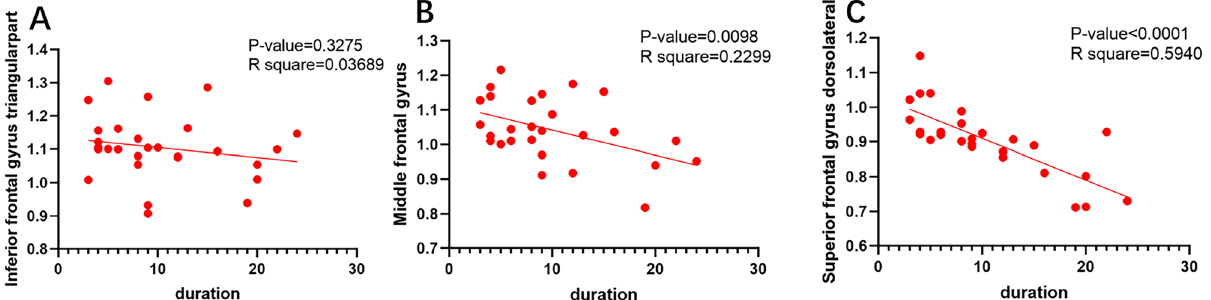
Figure 4. The correlation analysis between the course of the disease and the average ReHo of the brain area. ( A ) is the correlation between the ReHo value of awkward gyrus triangularpart and duration of disease (R square = 0.03689, P = 0.3275). ( B ) is the correlation between the ReHo value and duration of disease (R square = 0.2299). The P value is 0.0098. ( C ) shows the correlation between the ReHo value and duration of disease, R square = 0.5940, and P <